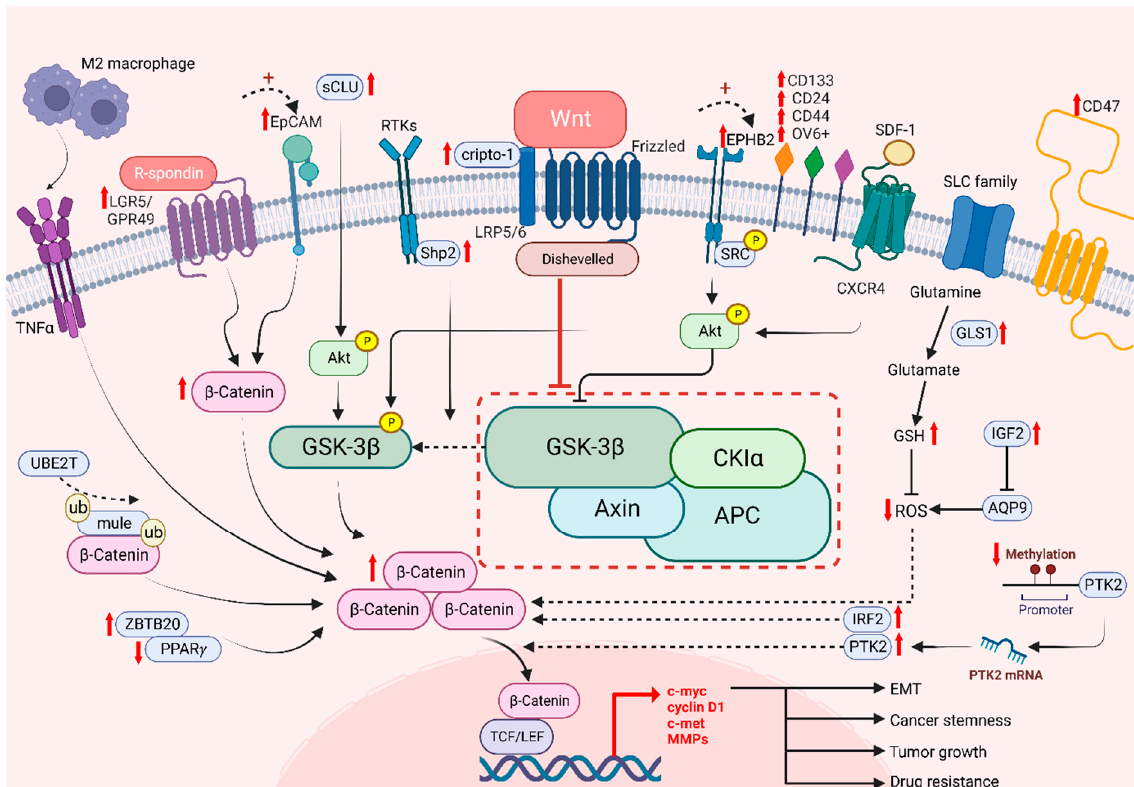
Figure 3. The role of Wnt/ β -catenin signaling on cancer stemness and drug resistance. Intrinsic and extrinsic regulation of Wnt/ β -catenin signaling lead to tumor growth, cancer stemness, EMT and drug resistance of HCC cells.